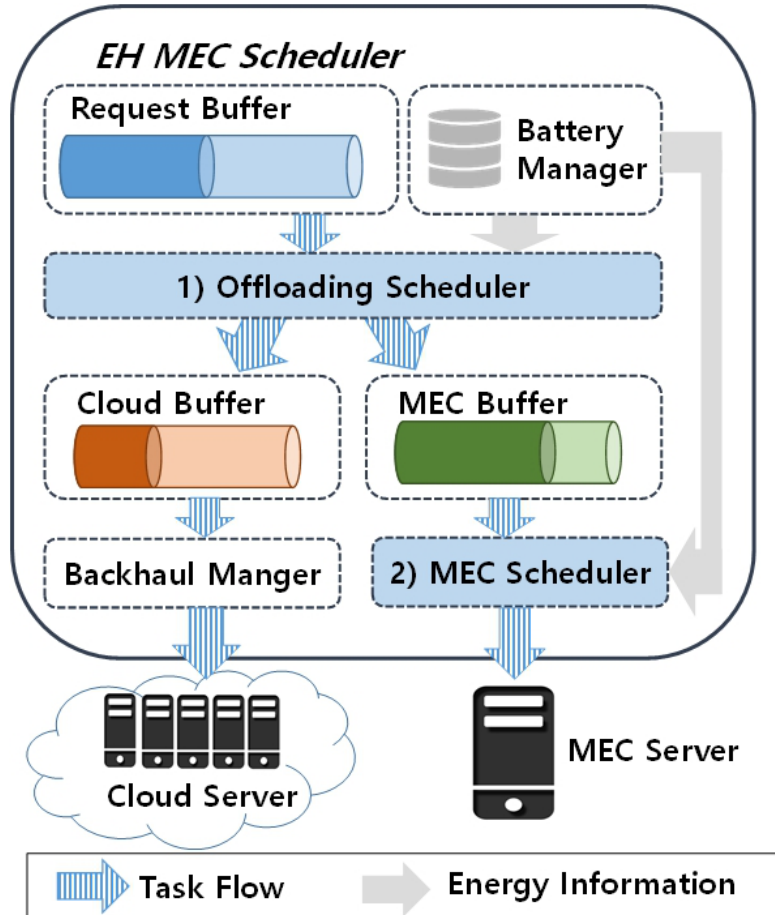
Figure 2. The proposed architecture of the EH MEC scheduler. The EH MEC scheduler includes two sub schedulers: (1) offloading scheduler; and (2) MEC